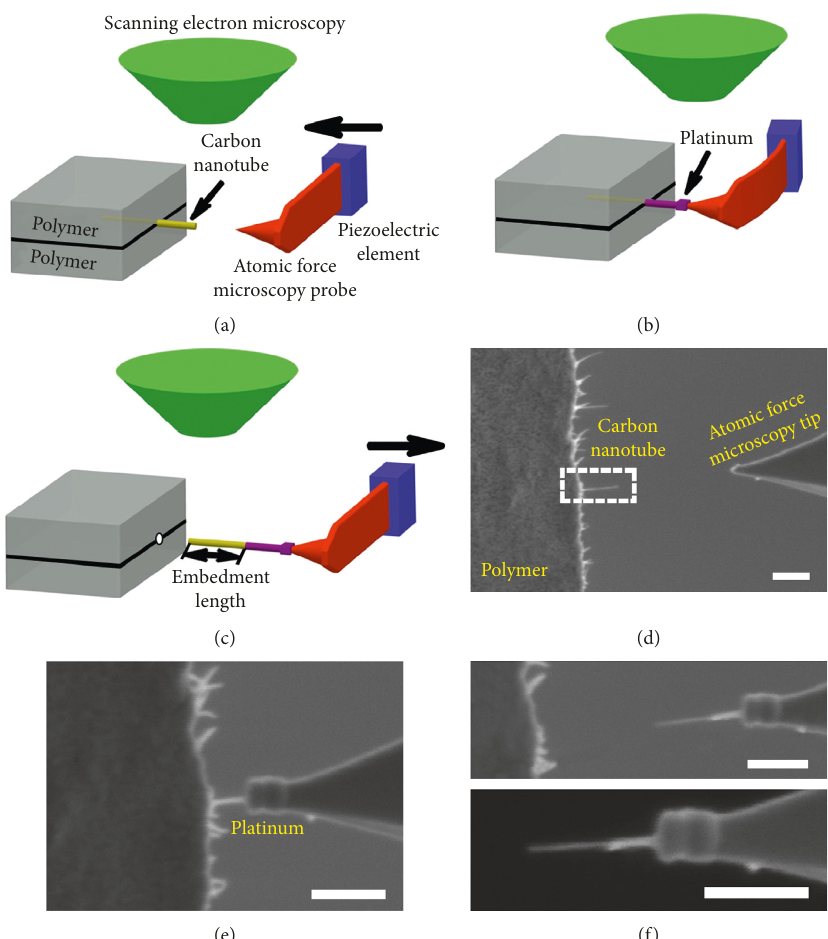
Figure 3: Schematic diagram of an individual carbon nanotube pull-out experiment and scanning electron microscope images of one representative individual carbon nanotube pull-out test: (a) a tip fixed to the cantilever of an atomic force microscope approaches the free end of an individual carbon nanotube embedded within a polymer matrix in a controlled way, (b) such a free end has been attached to the tip of the cantilever by means of electron beam-induced deposition of platinum, (c) the carbon nanotube has been pulled out from the polymer matrix completely, and (d)–(f) three scanning electron microscope images of the individual carbon nanotube pull-out test, corresponding to the schematic diagrams illustrated in (a)–(c), respectively. The lower right image in (f) is a zoom-in view of the carbon nanotube after being pulled out. Each of the scale bars represents 500nm (adapted with permission from reference [99]; copyright 2015, Elsevier